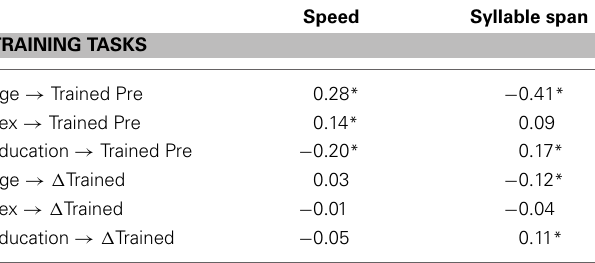
Table 8 | Standardized regression parameters for the analyses of the regression of training task variables on age, sex, and